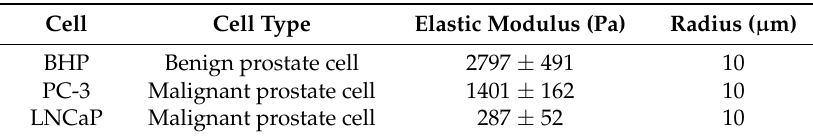
Table 4. Radius and elastic modulus of different cells types [30].